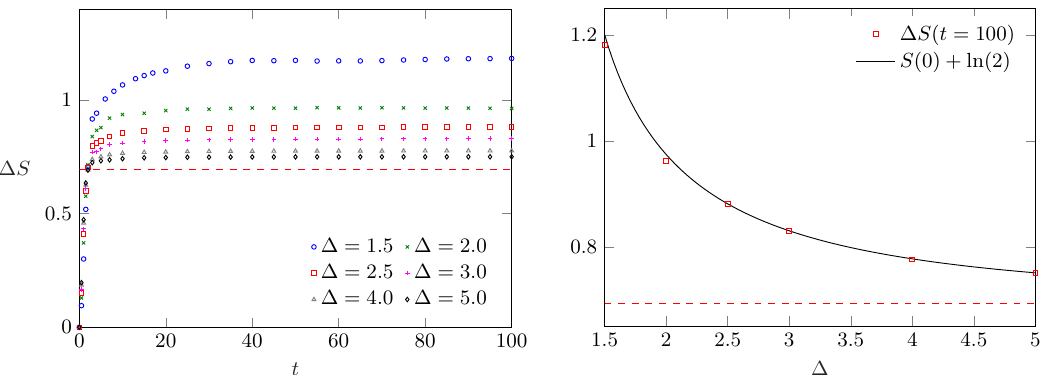
Figure 6: Left: Entanglement growth in the middle of the chain after a domain-wall excitation ˜ m for different values of ∆ > 1 and L = 400. Right: ∆ S at t = 100 1 compared to S ( 0 )+ ln ( 2 ) from Eq. (59). The red dashed line denotes ln ( 2 ) . Note the different vertical